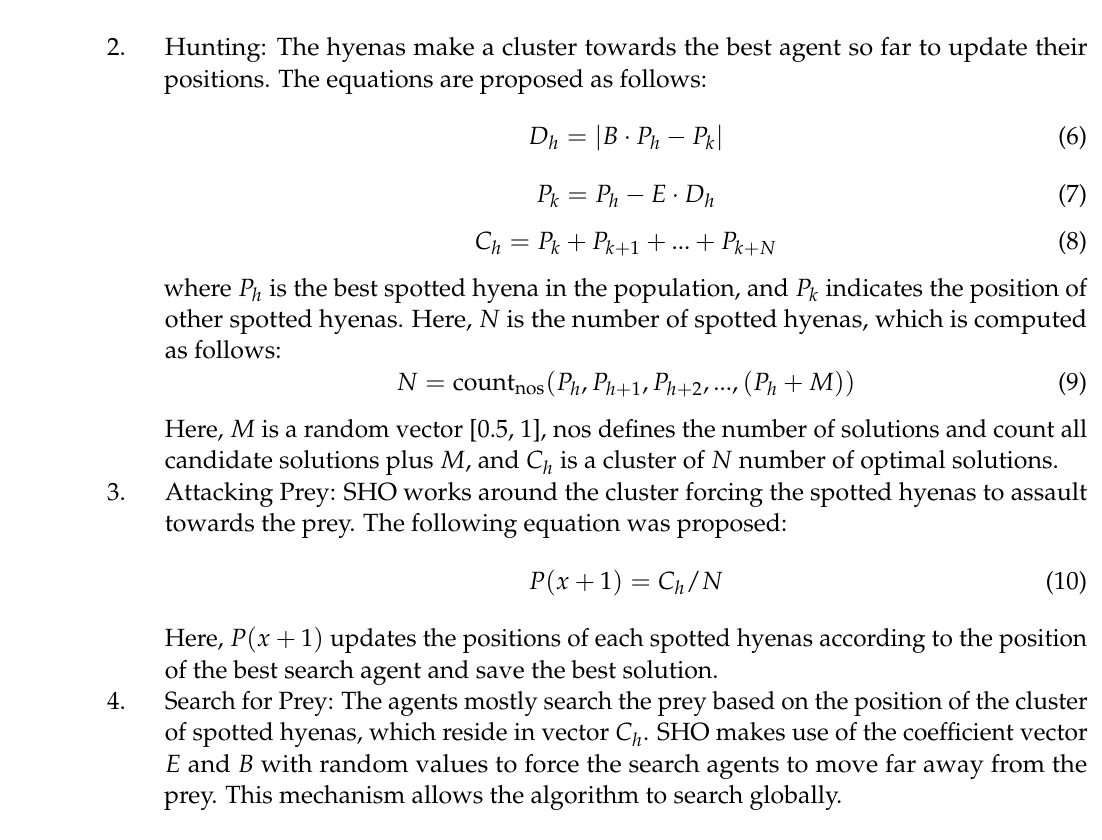
Table 1. Example of the standard work to be completed by the approach.